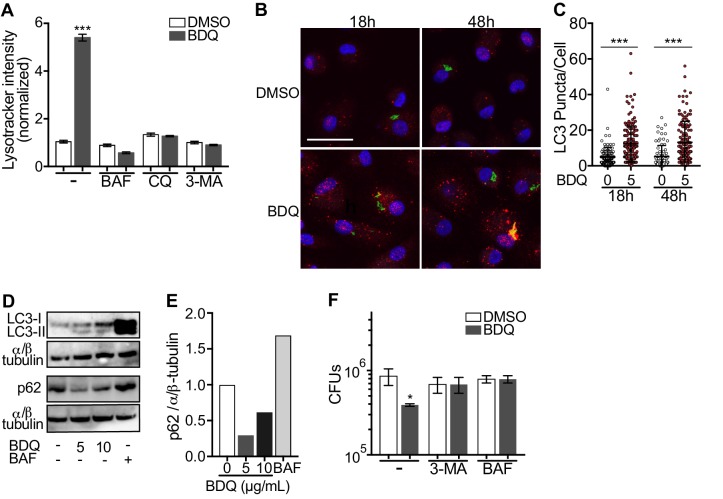
BDQ induced autophagy in MTB-infected macrophages.(A) BDQr-MTB-infected macrophages were incubated with BDQ (5 μg/mL) and different inhibitors of autophagy; bafilomycin (BAF, 100 nM), chloroquine (CQ, 40 μM) and 3-methyladenine (3-MA, 5 mM). After 48 hr, acidic compartments were stained with LysoTracker and fluorescence quantified by flow cytometry. (B) Detection by indirect immunofluorescence of LC3 (red) in BDQr-MTB (green) infected macrophages, treated with BDQ for 18 hr and 48 hr (scale bar: 10 μm). DAPI (blue) was used to visualize nuclei. (C) Determination of the number of LC3-positive puncta per cell (one-way ANOVA test). (D) Western blot analysis of LC3, p62, and α/ß-tubulin in MTB-infected cells treated with BDQ and BAF. (E) Densitometric quantification of p62 staining. (F) BDQr-MTB-infected macrophages were left untreated or incubated with BDQ, 3-methyladenine (3-MA) and/or bafilomycin (BAF). After 48 hr, the number of intracellular bacteria was enumerated. One representative experiment (of three) is shown. Error bars represent the mean ± SD. *p<0.05, **p<0.01, ***p<0.001.